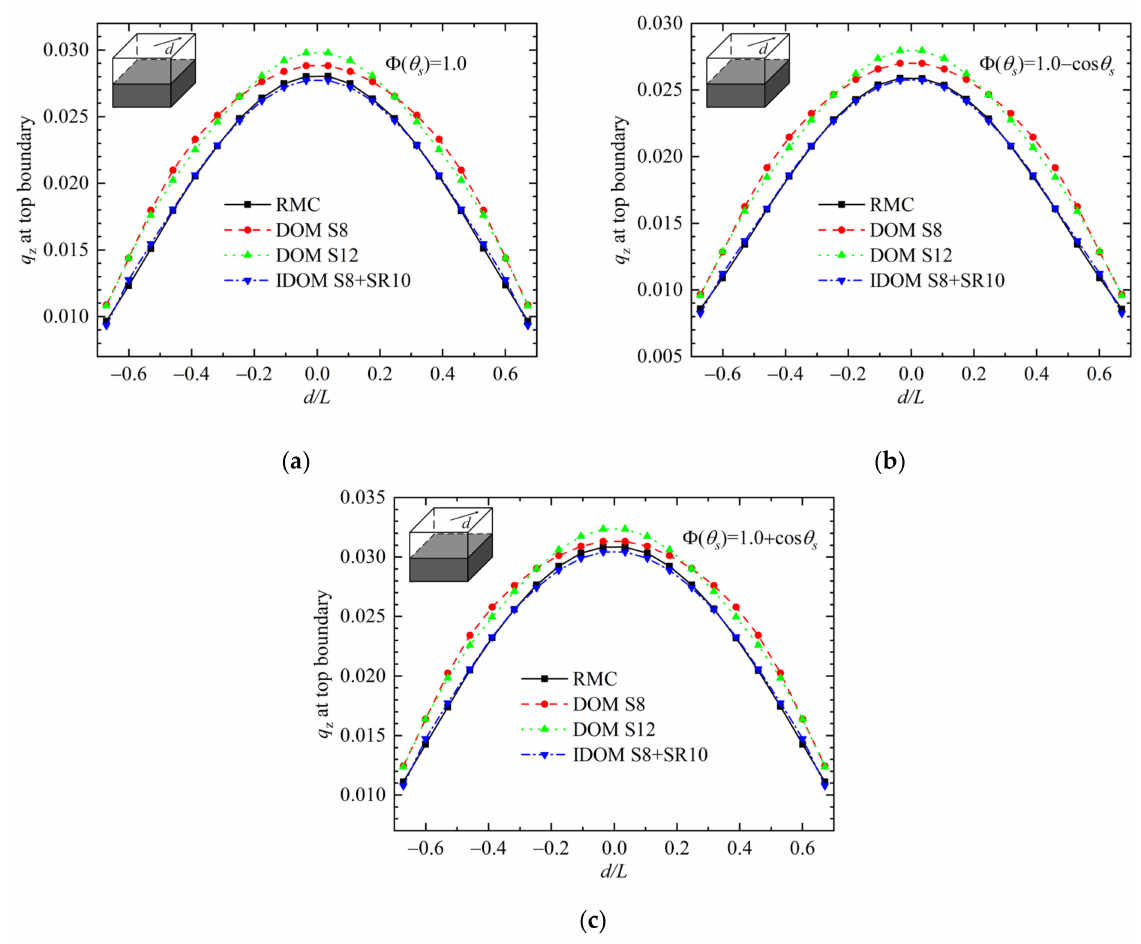
Figure 4. Heat flux at the boundary of Case 2: ( a ) results for A 1 = 0; ( b ) results for A 1 = − 1; ( c ) results for A 1 =